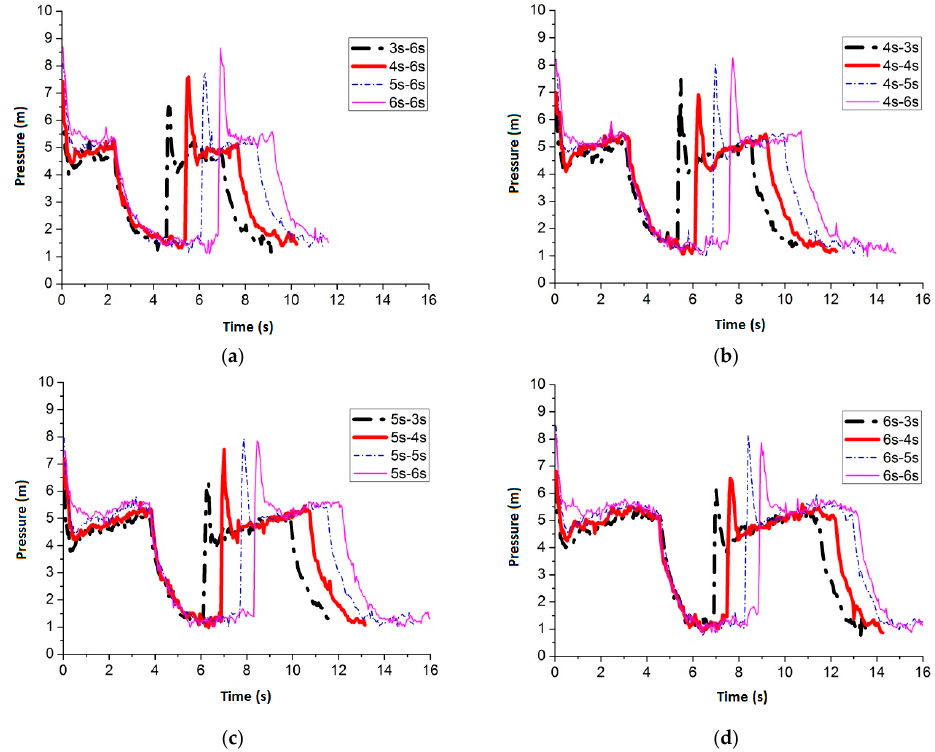
Figure 18. Pressure fluctuation of No. 1 sensing point (rectangular nozzle at the bottom of the pipe): ( a ) air inflow time is 3 s; ( b ) air inflow time is 4 s; ( c ) air inflow time is 5 s; and ( d ) air inflow time is 6 s.